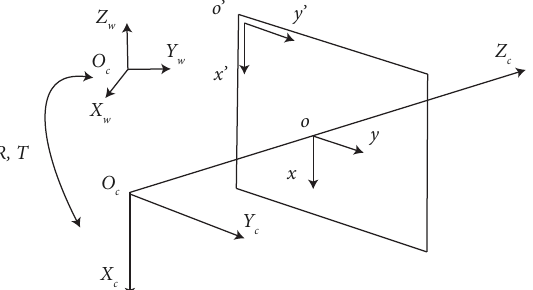
X Y Z ) , camera coordinate system ( O w w w w